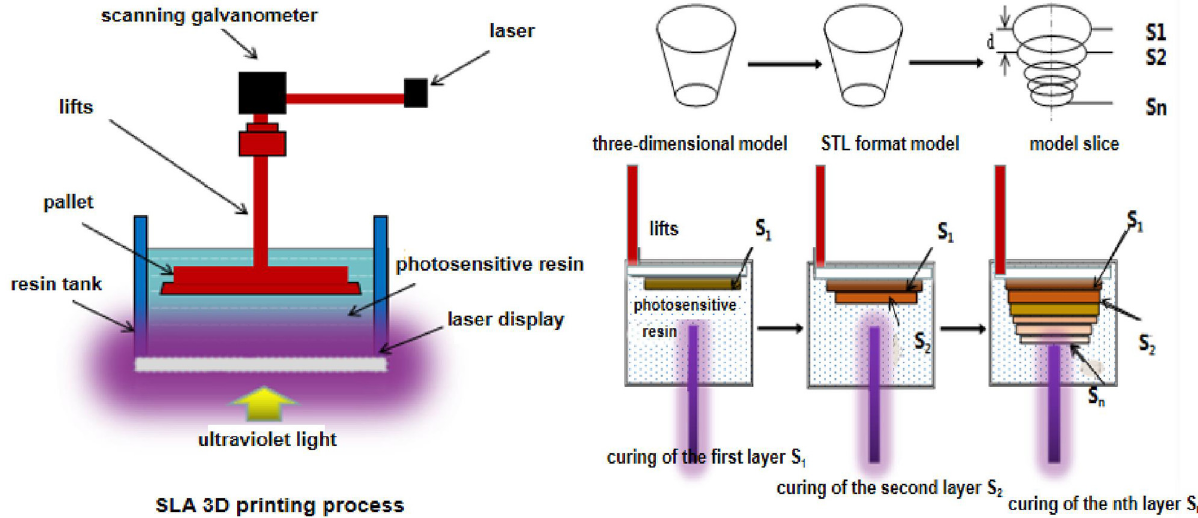
Figure 2: SLA 3D printing process.